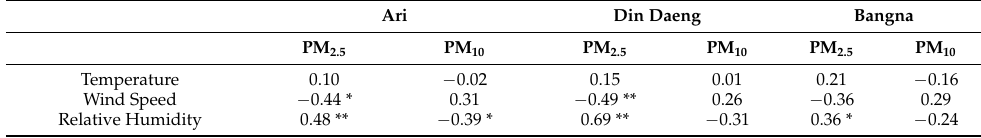
Figure 3. PM and its carbonaceous species at Ari, Din Daeng, and Bangna, Bangkok, Thailand. Table 2. Spearman’s rank correlation between PM 2.5 , PM 10 , and meteorological